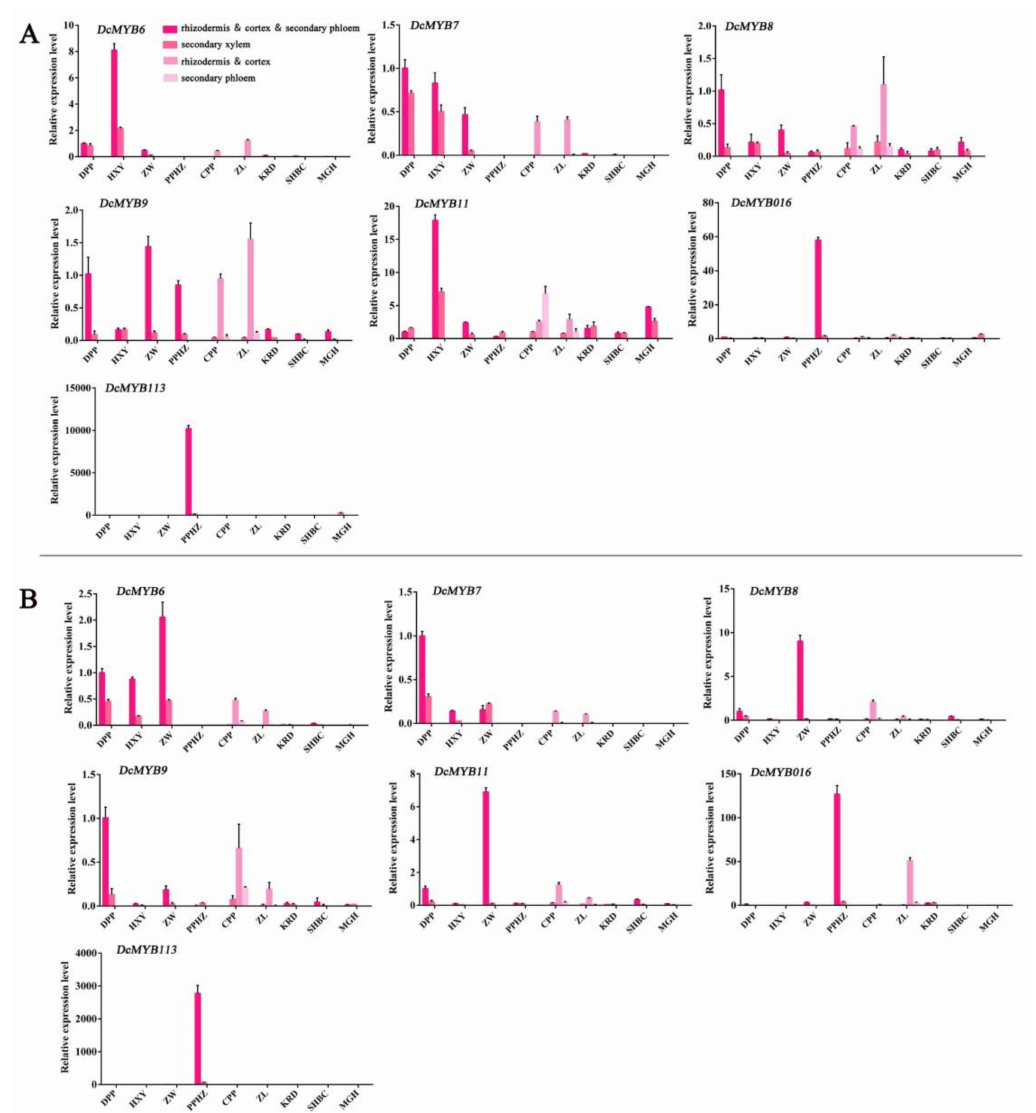
Figure 9. Expression profiles of S6 subfamily DcMYB genes (DcMYB6 (DCAR_000385), DcMYB7 (DCAR_010745), DcMYB8 (DCAR_010746), DcMYB9 (DCAR_010747), DcMYB11 (DCAR_010751), DcMYB016 (DCAR_016451) and DcMYB113 (DCAR_008994)) in different root tissues of carrot at two growth stages. ( A ) represents expression profiles of DcMYB genes in purple and nonpurple carrots at 70 days after sowing. ( B ) represents expression profiles of DcMYB genes in purple and nonpurple carrots at 110 days after sowing. The relative gene expression was calculated with the 2 − ∆∆ CT method. Error bars represent standard deviation (SD) of three